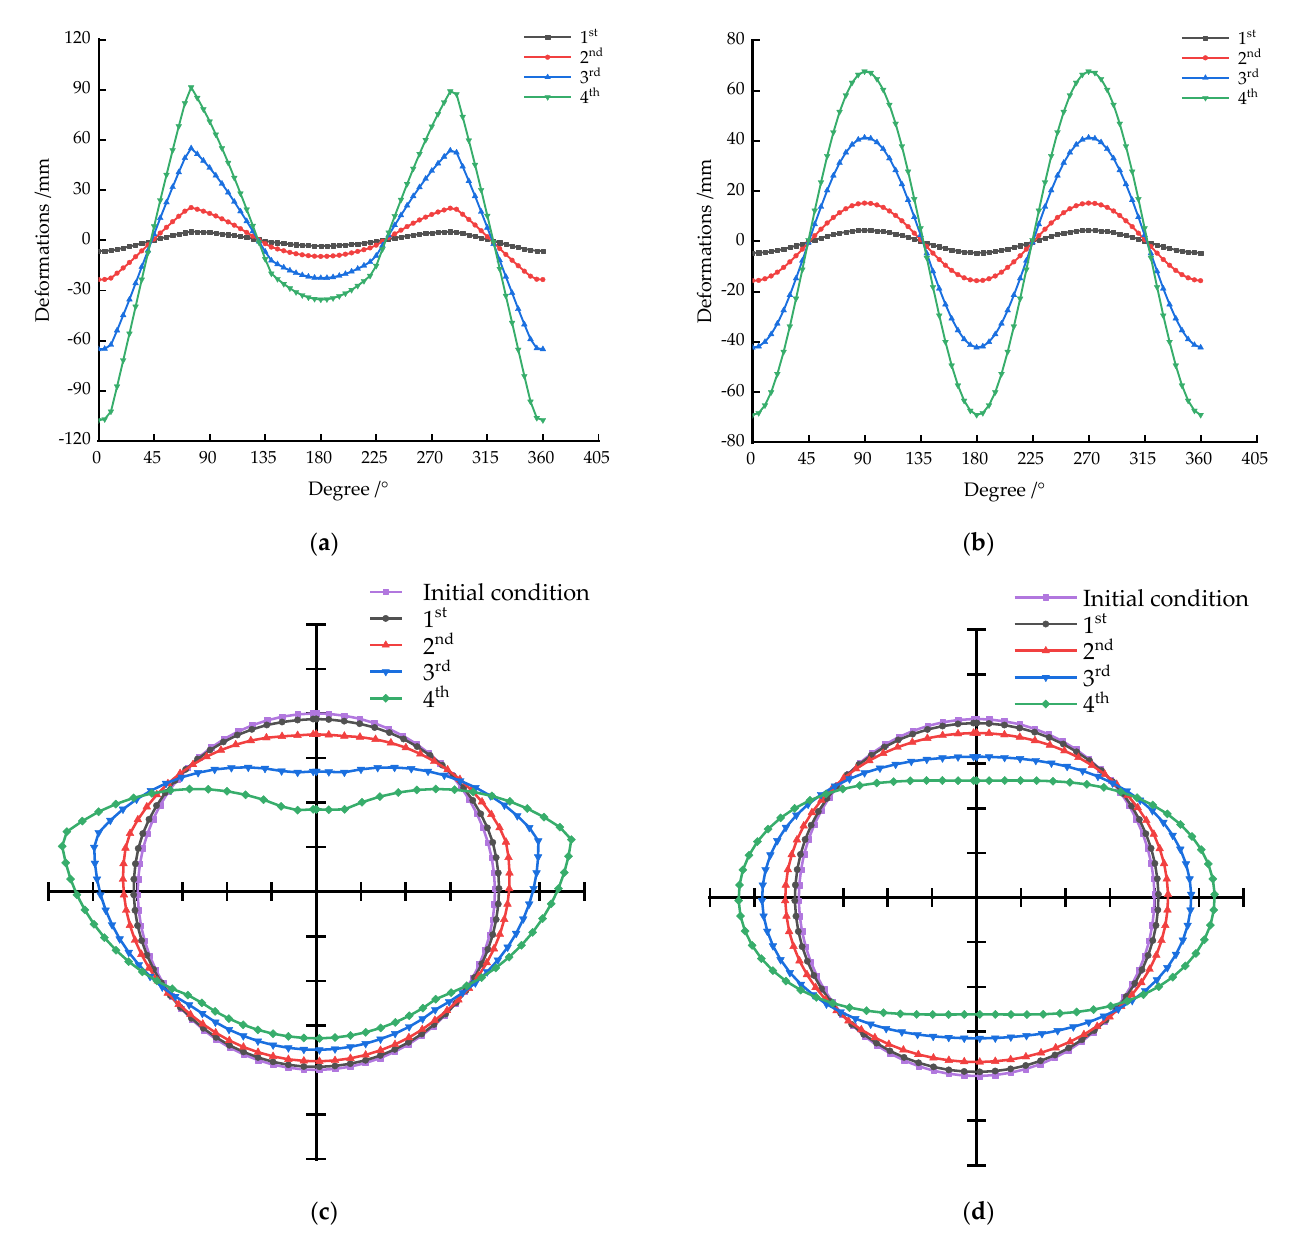
Figure 4. Simulated deformations under different loading conditions (unit: mm): ( a ) Beam-spring model; ( b ) modified uniform rigidity ring model; ( c ) deformation’s comparison of the beam-spring model; ( d ) deformation’s comparison of the modified uniform rigidity ring model (in order to better reflect the deformation of ( a , b ), the different segment ring model’s deformation are amplified 15 times in ( c , d )).